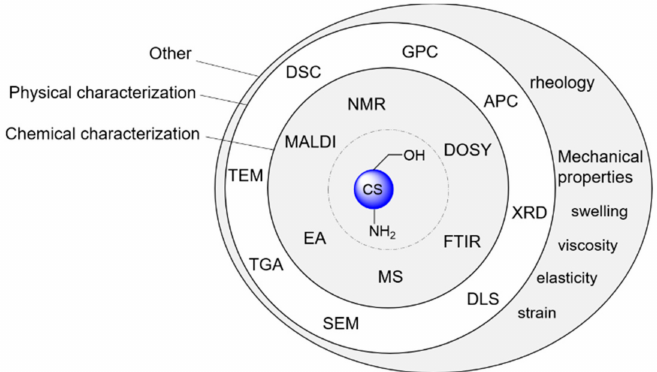
Figure 12. Summary of techniques for CS characterization: chemical characterization (internal circle), physical characterization (intermediate circle), and other characterizations (external